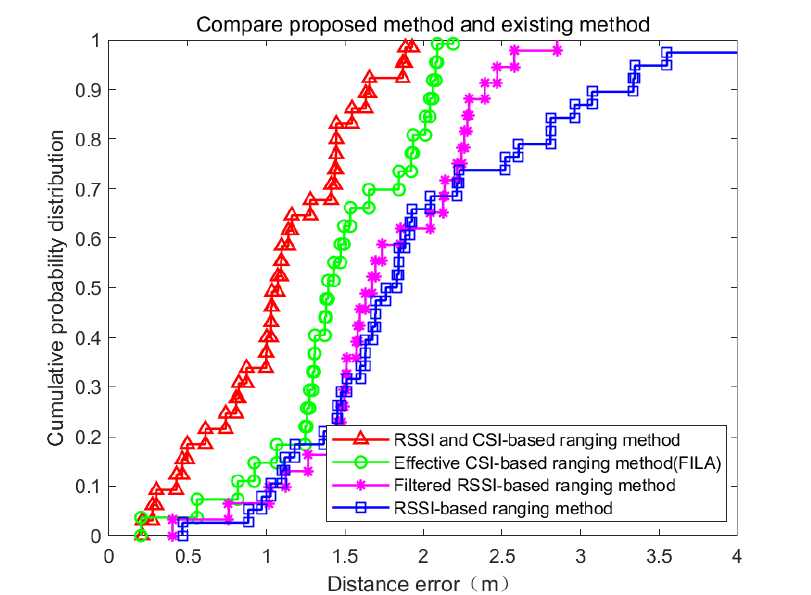
Figure 19. Cumulative Distribution Function (CDF) of distance errors with the four ranging algorithms in IT-2 building.